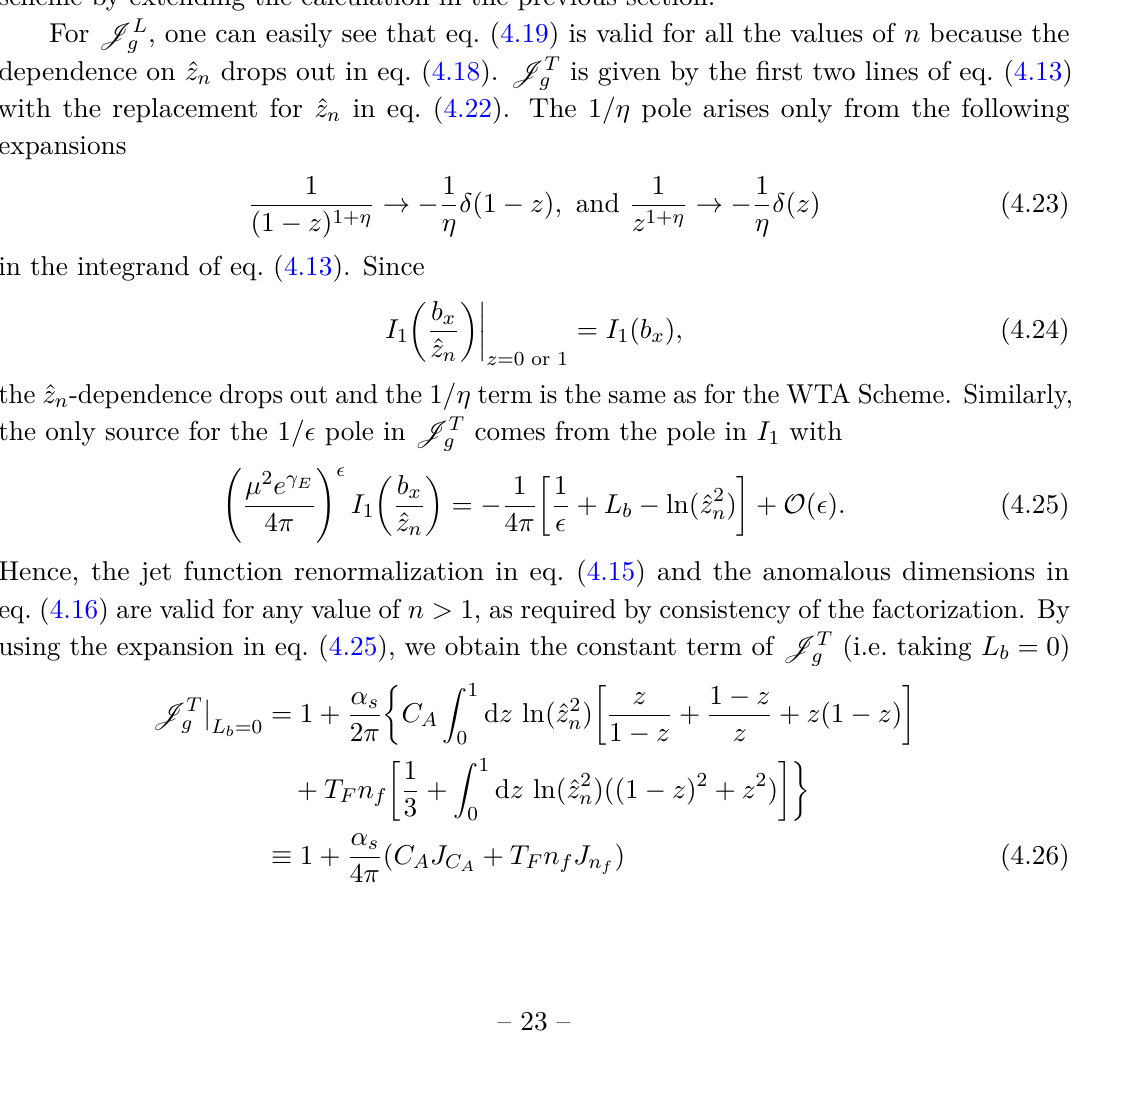
) and quarks ( J n ) to the A f , J n and A f